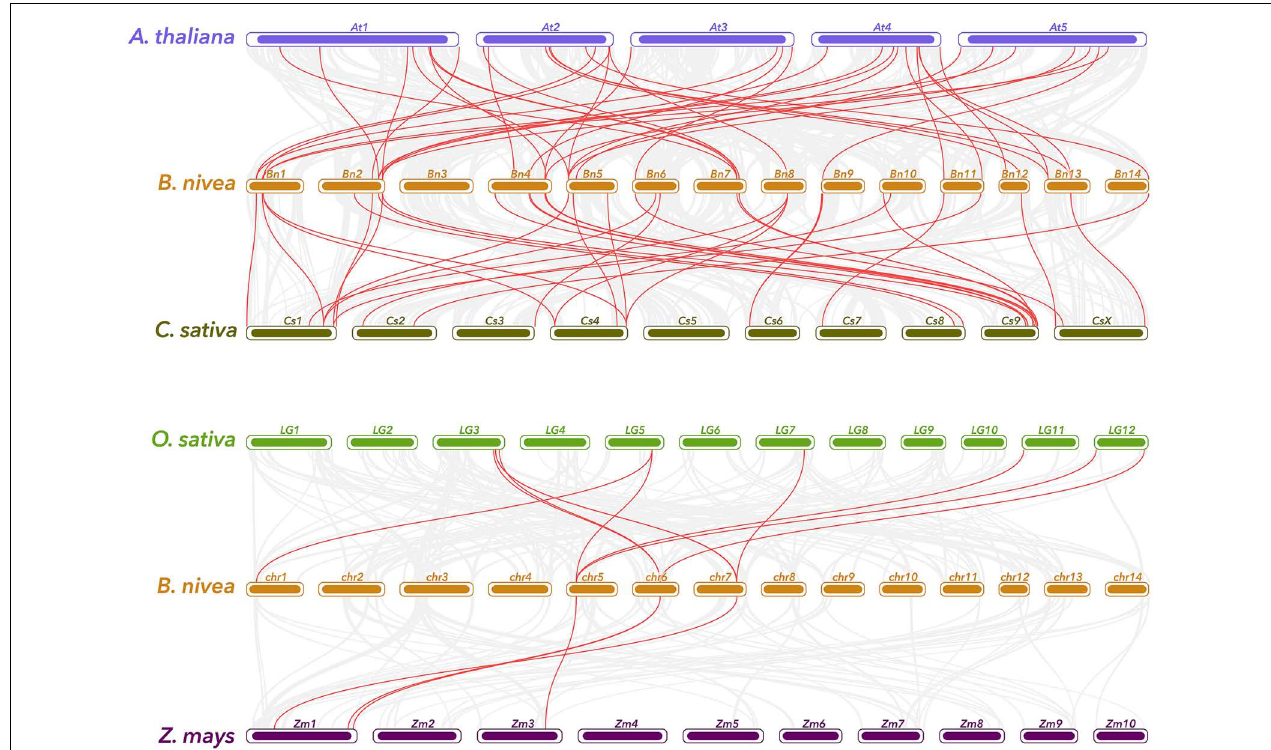
FIGURE 5 | Gene duplication and synteny analysis of WRKY genes between ramie and four representative plant species. Gray lines in the background indicates the collinear blocks within ramie and other plant genomes, while the red lines highlight the syntenic WRKY gene pairs. The specie names with the prefixes “ B. nivea